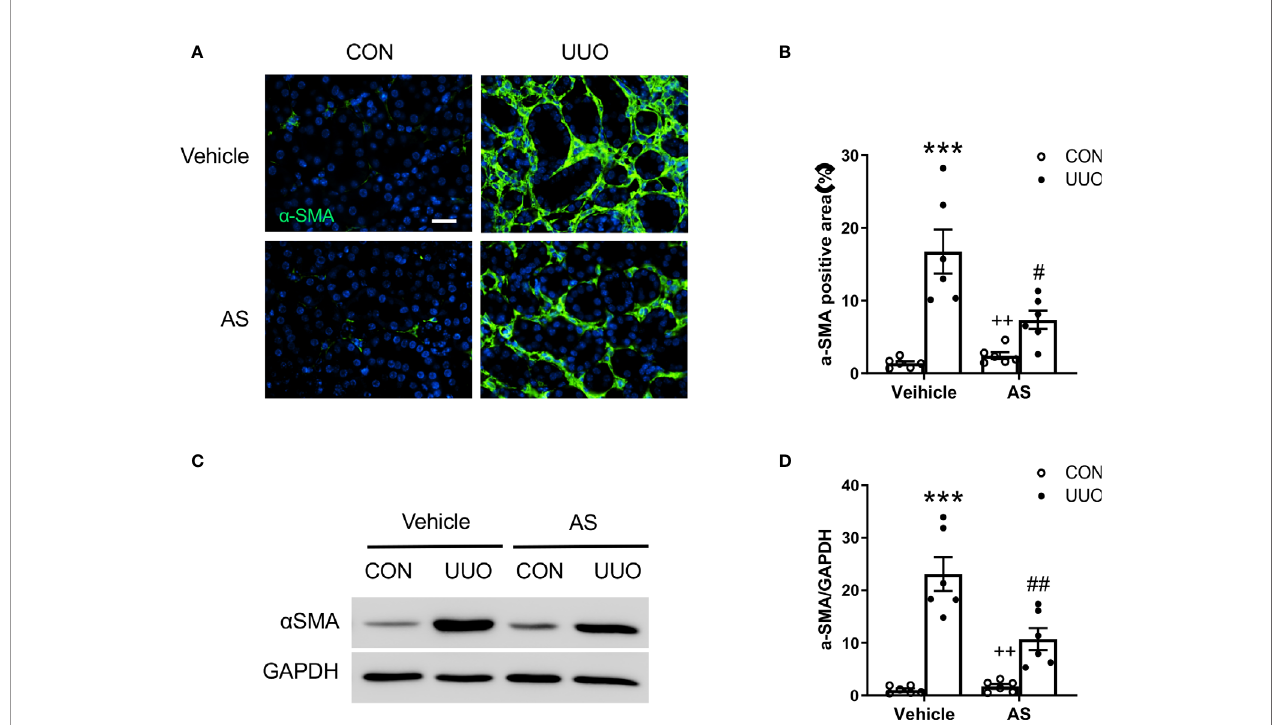
FIGURE 3 | AS1517499 reduces myo fi broblast formation in the kidney with obstructive injury. (A) Representative photomicrographs ofUUO treated kidney sections stainedfor a -SMA(green) and counterstained with DAPI (blue).Scalebar,50 m m. (B) Quantitative analysis of a -SMApositive area in the kidney. *** P < 0.001 vs Vehicle-CON, # P < 0.05 vs Vehicle-UUO, ++ P < 0.01 vs AS-UUO.n = 6 per group. (C) Representative Westernblots show a -SMA protein levelsin the kidney. (D) Quantitative analysis of a -SMA protein expression in the kidney. *** P < 0.001 vs Vehicle-CON, ## P < 0.01 vs Vehicle-UUO, ++ P < 0.01 vs AS-UUO. n = 6 per